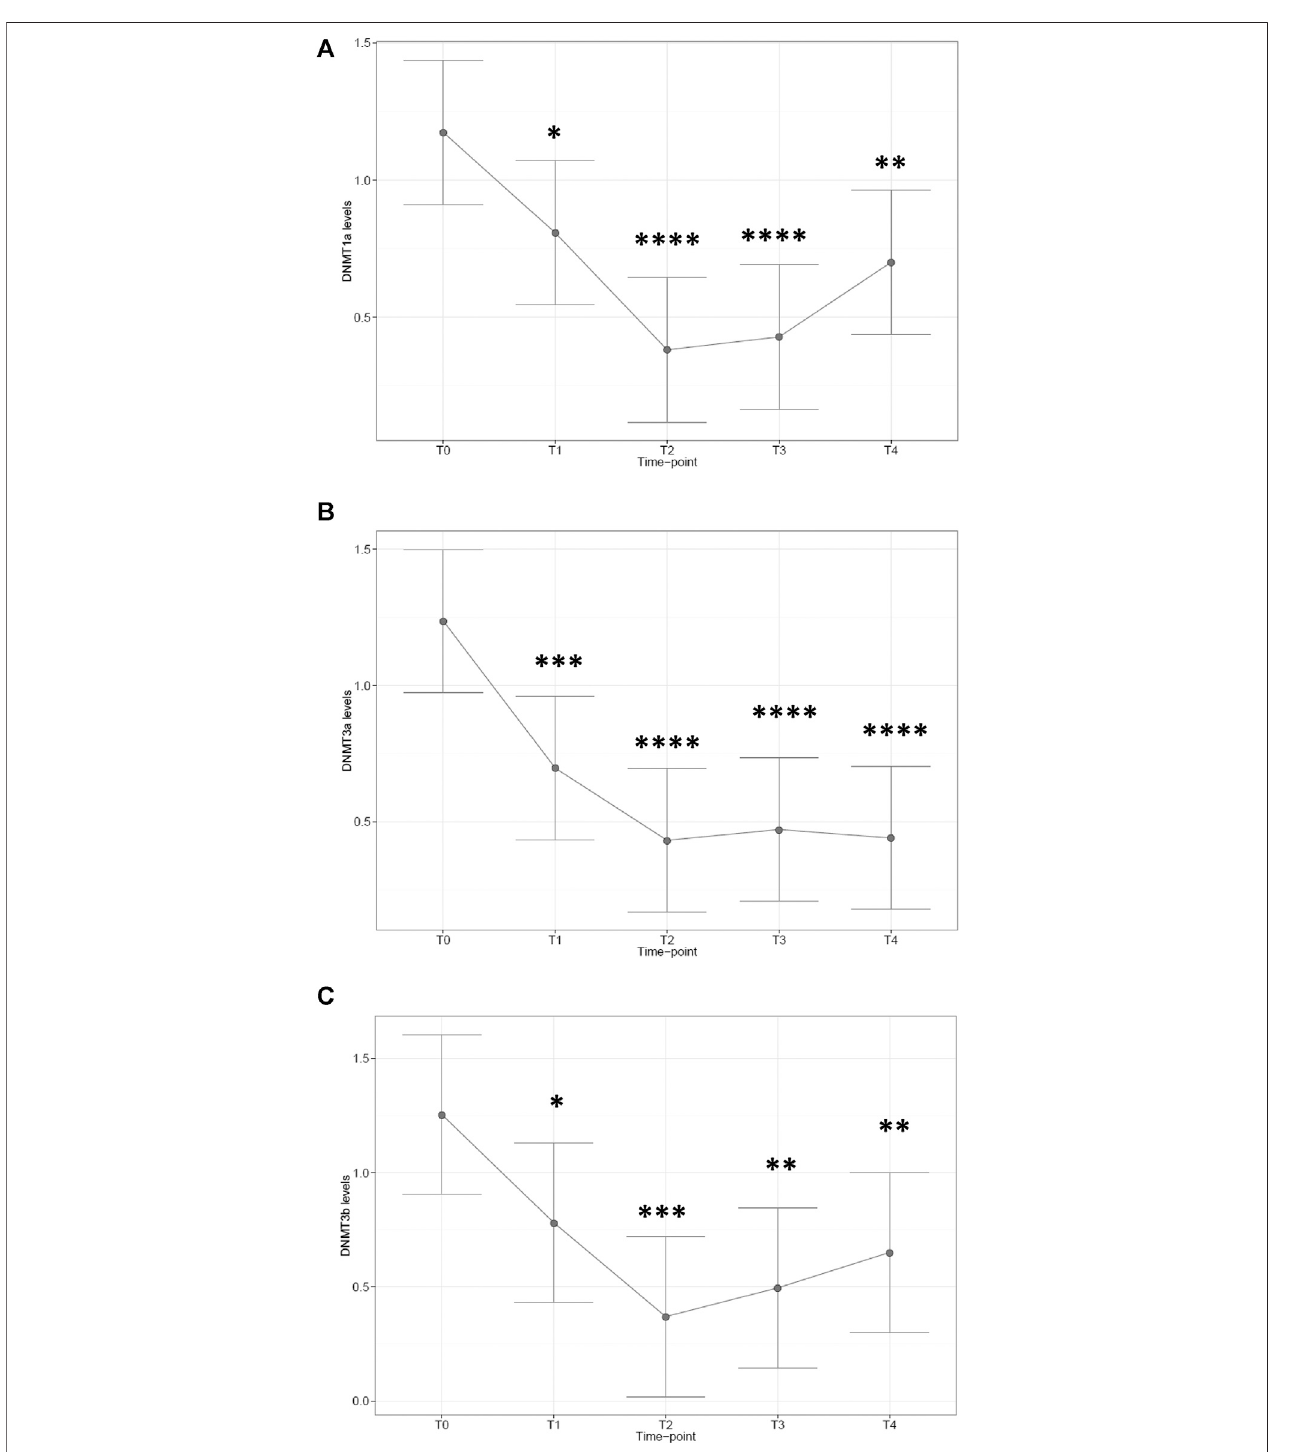
FIGURE2| mRNAexpressionofDNAmethyltransferaseisoformsinpatientsatdifferenttime-points.Plotoftheleastsquarepredictedmeanswith95%con fi dence intervals.Thepredictedleastsquaremeanswerecalculatedusinga1-wayrepeatedmeasuresmixedmodel. (A) :DNMT1a; (B) :DNMT3a; (C) :DNMT3b.* p < 0.05;** p < 0.01; *** p < 0.001; **** p < 0.0001 in planned comparisons with T0 levels. n (cid:2) 11 patients repeatedly assessed at 5 time-points.